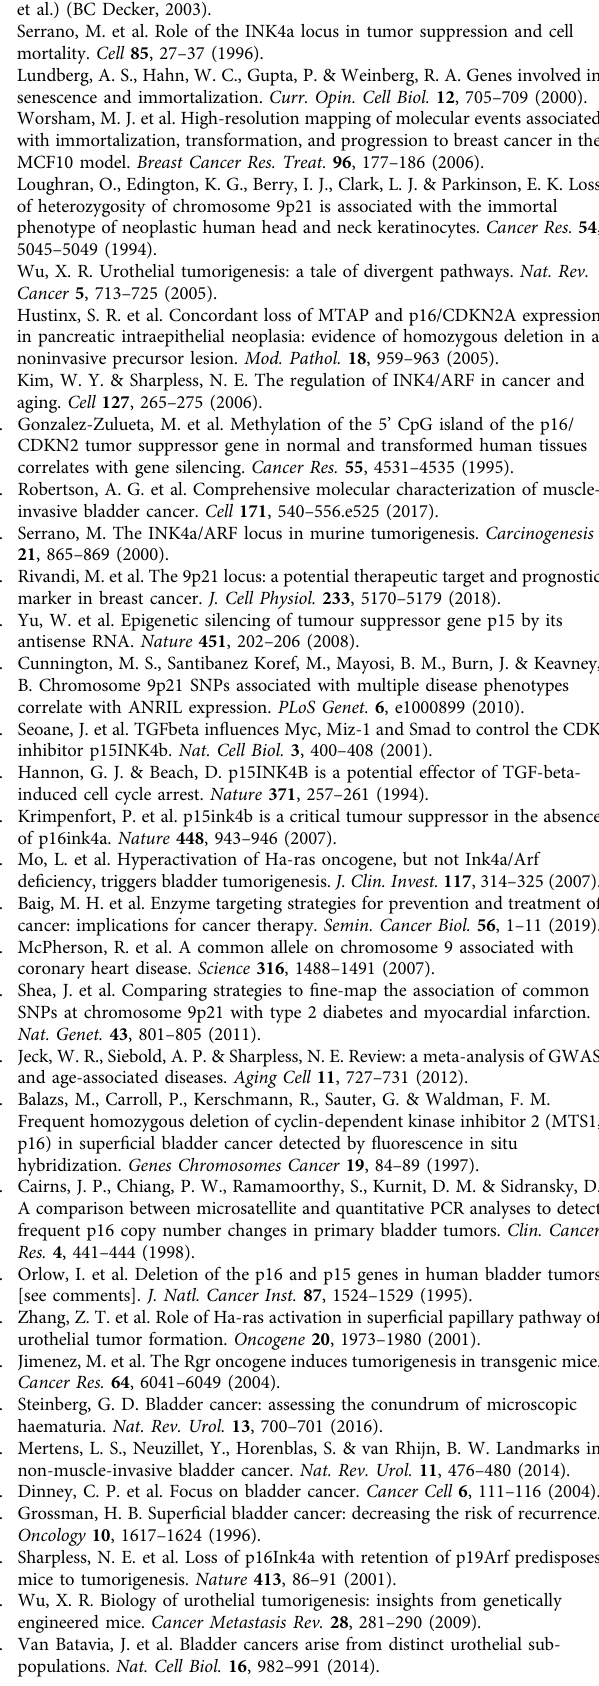
(Supplementary Table 4). The secondary antibodies used were: horse anti-mouse IgG antibody (1:5000, Cell Signaling Technology), goat anti-rabbit IgG antibody (1:5000, Cell Signaling Technology), and goat anti-chicken (1:3000, Invitrogen). For semi- quanti fi cation, the band densities were measured using ImageJ software. Uncropped gels and blots that are the most important to our conclusions are provided in the Source Data as a Source Data fi le. Statistical analysis . Data were shown as mean ±SD from at least three separate experiments and/or at least three biologically independent samples.